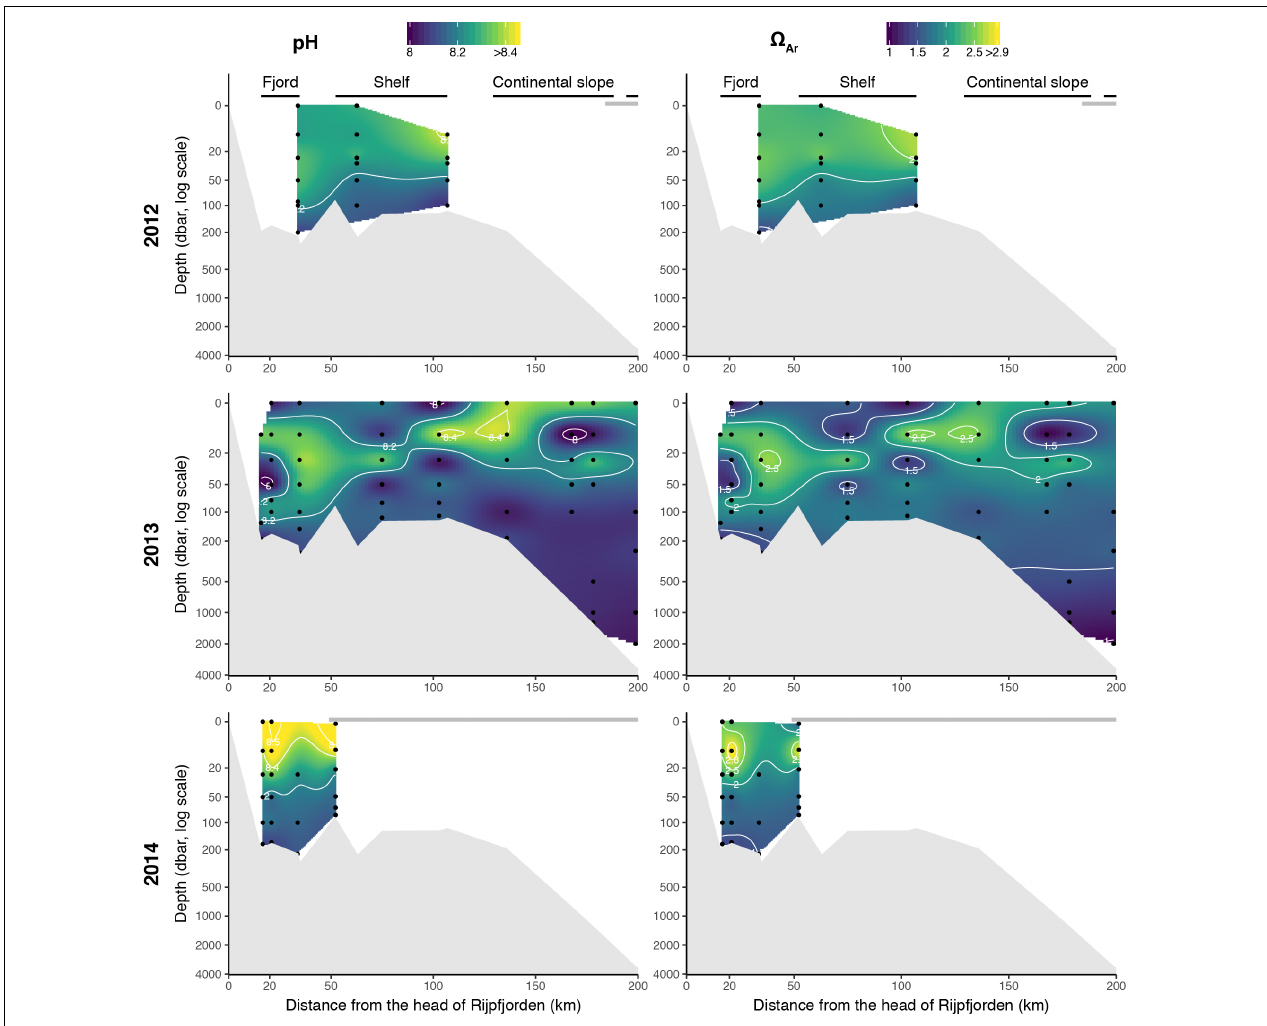
FIGURE 4 | pH and aragonite saturation ( (cid:127) Ar ) along the Rijpfjorden transect, July–August 2012–2014. Gray horizontal line at 0 m indicates the extent of consolidated pack ice.